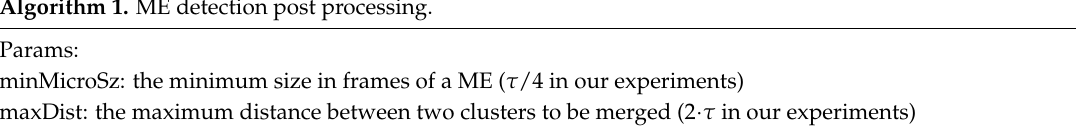
Algorithm 1. ME detection post